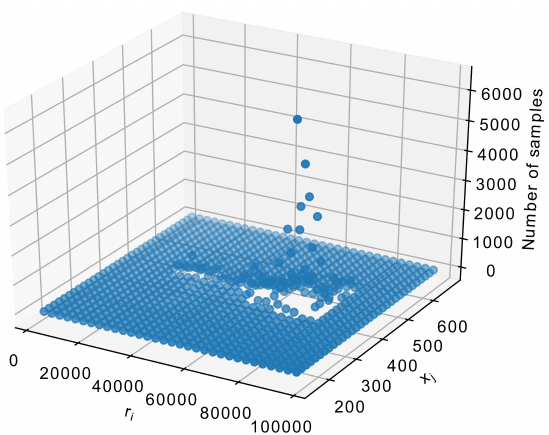
Figure 4. Number of samples in the grid (reduced to 32 × 32 for display’s